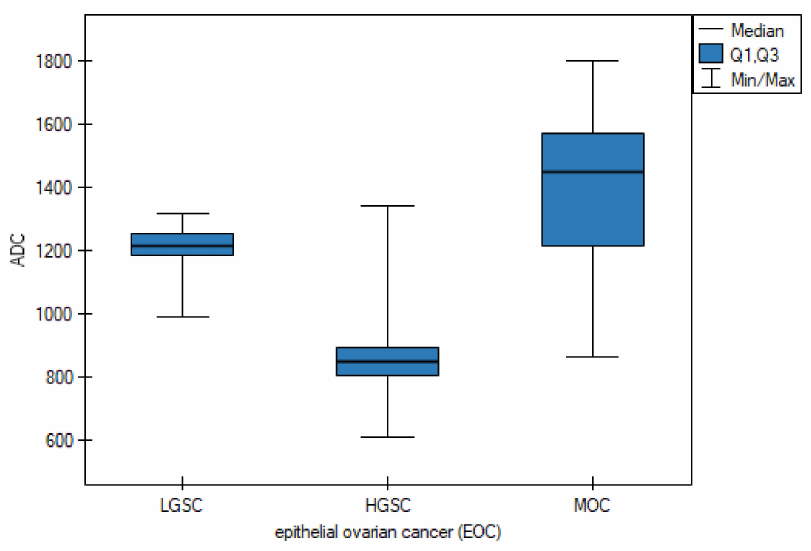
Scheme 2. Comparison of ADC parameters between LGSC, HGSC and MOC.